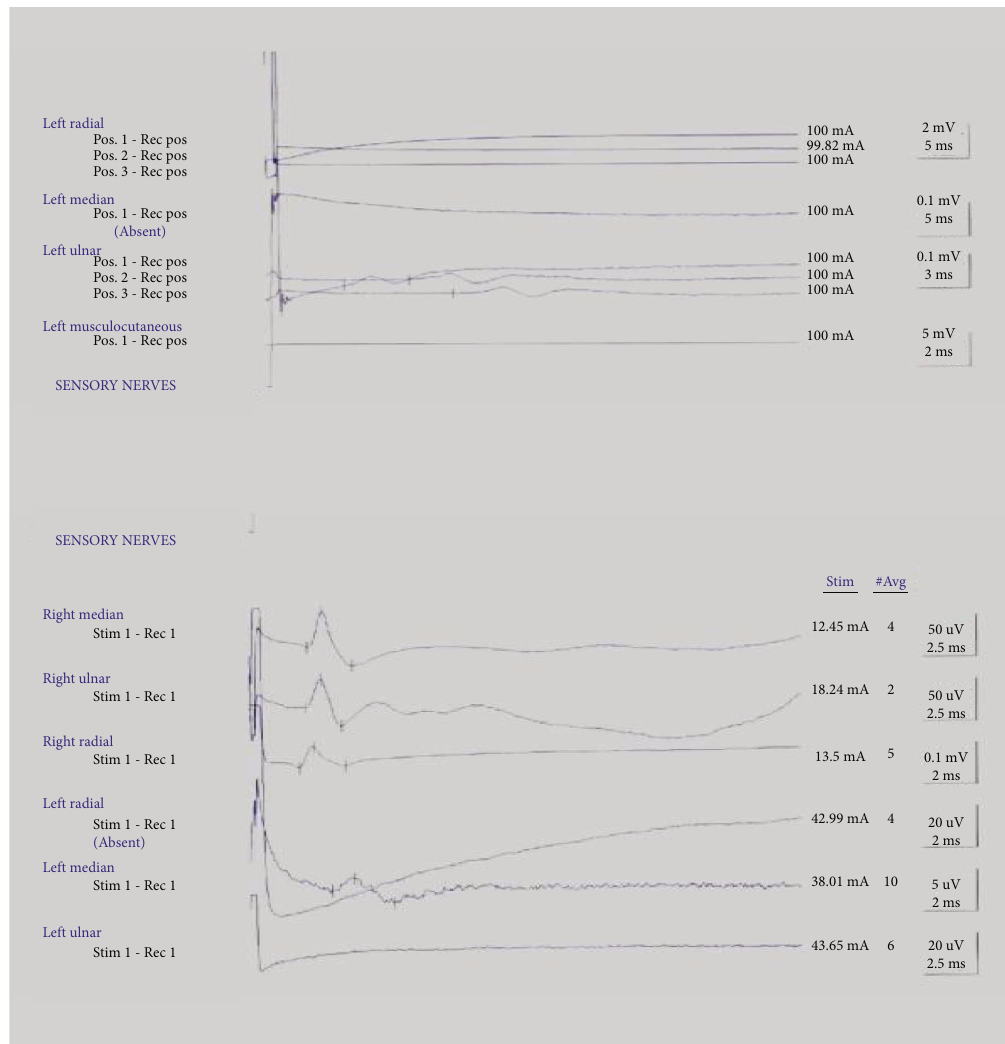
Figure 4: Nerve conduction studies of the upper